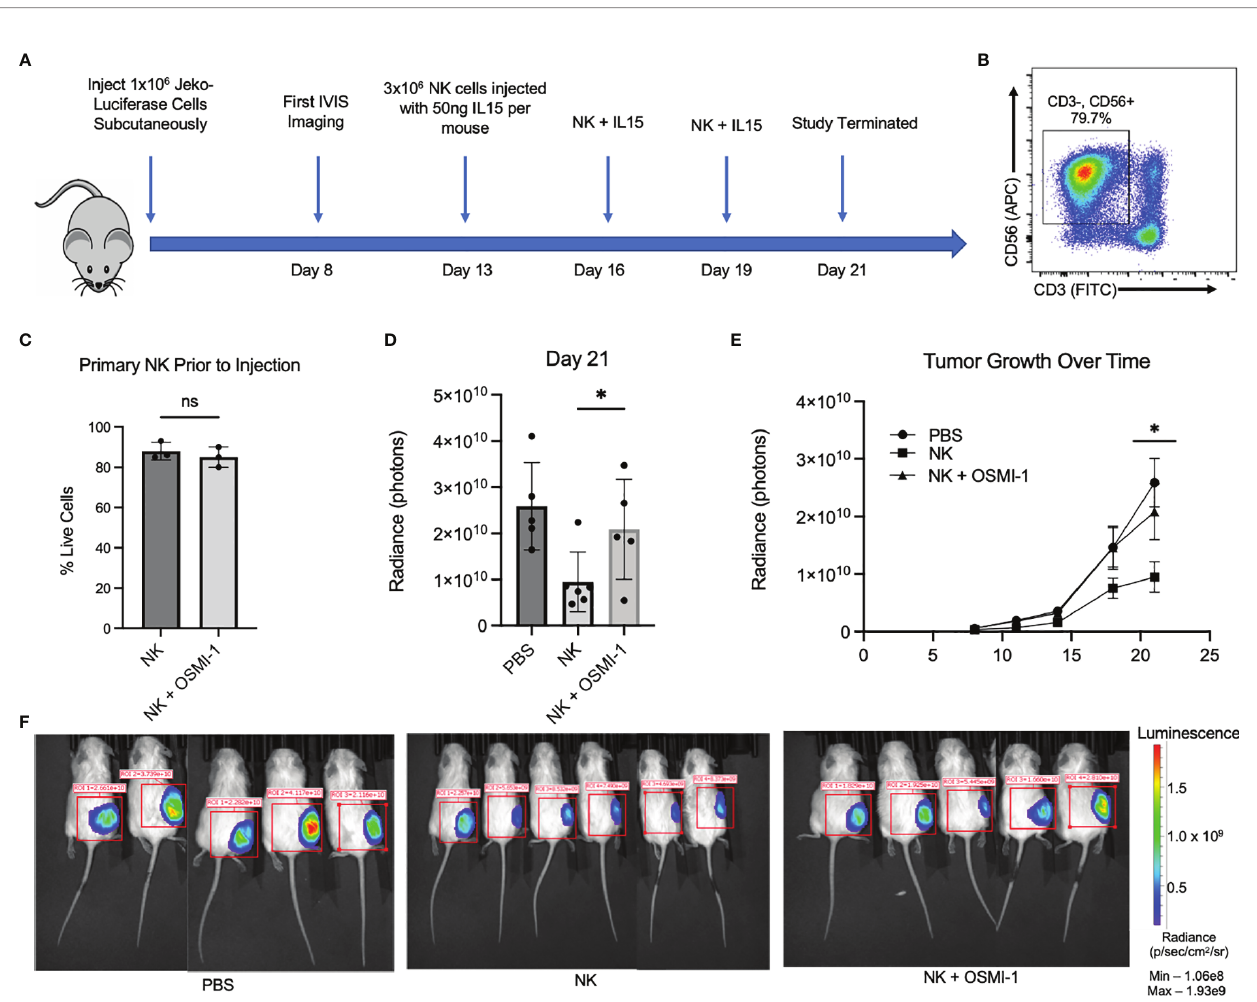
FIGURE 5 | OSMI-1 pretreatment of primary NK cells inhibits cytotoxicity in vivo. Mice were inoculated with 1 × 10 7 Jeko-luciferase cells subcutaneously. Beginning at Day 11, mice were injected with PBS (sham) or 3 million primary NK cells with or without 36 h of incubation with OSMI-1 (25 µM) every 3 days with In Vivo Imaging System (IVIS) measurements being taken every 3 – 4 days. IL-15 was added to cell suspension at 50 ng per mouse just prior to injection. (A) Schematic representation of in vivo experimental design. Panel (B) shows primary NK cell population at time of injection de fi ned as CD3-/CD56+. (C) Primary NK live/dead staining 1:1 with trypan blue via Countess after 36-h incubation with OSMI (25 µM) taken just prior to injection. (D) Radiance (photon) expression of IVIS imaging of individual mice at Day 21 normalized to same scale. (E) Line graph of average increase per treatment group in photons per constant ROI as measured by IVIS with error bars displaying standard error of the mean. Panel F shows luciferase IVIS images for mice at Day 21. PBS and OSMI-1 groups had n = 5, and NK-only group had n = 6. Images normalized to same IVIS spectrum sensitivity range. NS indicates no signi fi cance. * indicates signi fi cance of p <.05 as determined by Student ’ s unpaired T-test between untreated NK and NK + OSMI-1 group. Experiments in panels (B, C) were performed once at each indicated time point. Figure 1C has 3 individual data points from samples taken from the cellular population prior to injection. 1B is representative across the 3 time points of